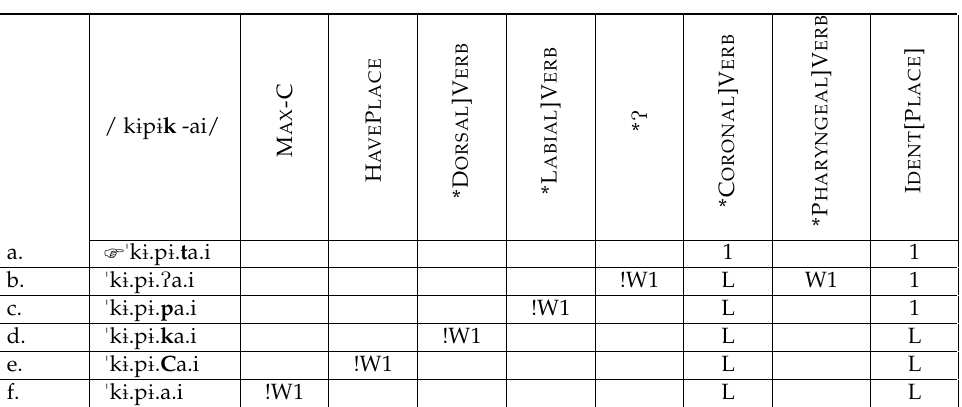
stem. Thus, for example, when the prefix /k 1 -/ ‘in the lip(s)’ is added to the root /p 1 ka/ !W1 L ‘to punch holes’ in (33), the resulting stem is /k 1 p 1 k / ‘to punch holes in (his) lip(s)’. The apocope should have left the /k/ of /p 1 ka/ as the final consonant, but since it is a stop Unlike Shipibo-Konibo, latent segments in Capanahua surface as labial in non-verb consonant it becomes a latent segment when parsed as a coda (/k 1 p 1 k -k 1 / → [k 1 . " p 1 k.k 1 ] → forms. Table 4 shows that the ergative form of the same noun shown in Table 3, /kap ɨ C - [k 1 . " p 1 .k 1 ] ‘(s/he) punched holes in (his) lip’). However, it surfaces not as a dorsal consonant aN/ ‘alligator’ surfaces as [ ˈ ka.p ɨ . p ãN] in Capanahua, with the latent segment mapped as but as a coronal when it is parsed as an onset (/k 1 p 1 k -ai/ → [ " k 1 .p 1 . t a.i] ‘(s/he) is punching a labial consonant, [p]. This result is obtained through the same ranking of constraints but holes in (his) lip’). Thus, it does not matter what the original PoA was (the segment could this time, with *D ORSAL ] N ON V ERB outranking *L ABIAL ] N ON V ERB . be placeless or specified for any place), when the morpheme-final latent consonant surfaces as an onset in a verb form, it always appears as coronal, [t]. This behavior is illustrated in Table 4. /kap ɨ C -aN/ → [ ˈ ka.p ɨ . p ãN] ‘alligator’ (/N/form)—Capanahua. Table 2. Table 2. /k 1 p 1 k -ai/ → [ " k 1 .p 1 . t a.i] ‘(s/he) is punching holes in (his) lip’ (Shipibo-Konibo).